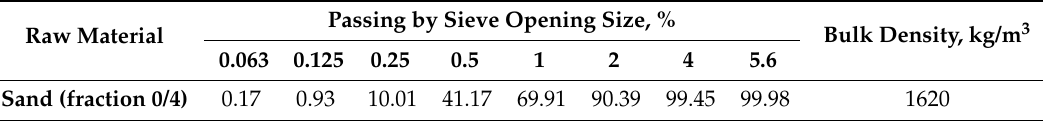
Table 3. The granulometric composition and the bulk density of 0/4